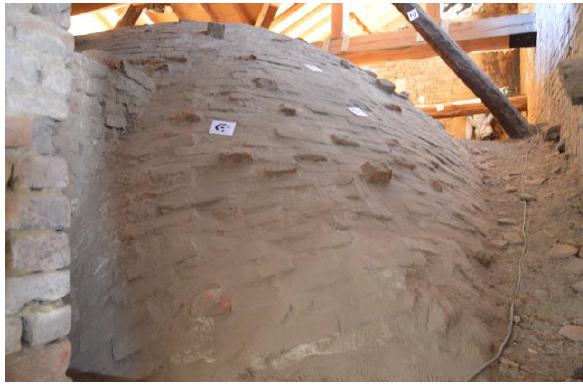
Figure 2. Magio Grasselli Palace: extrados of the staircase vault (Room 1.26).